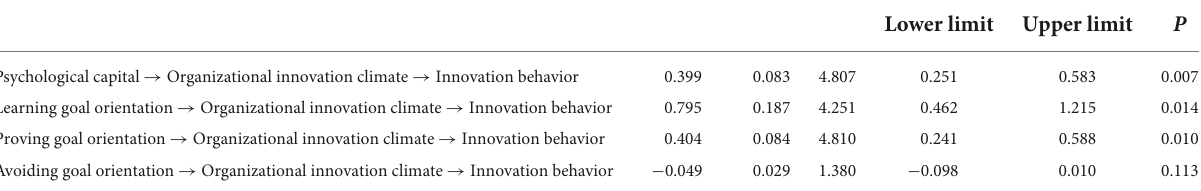
TABLE 6 Moderating effect test of organizational innovation climate.